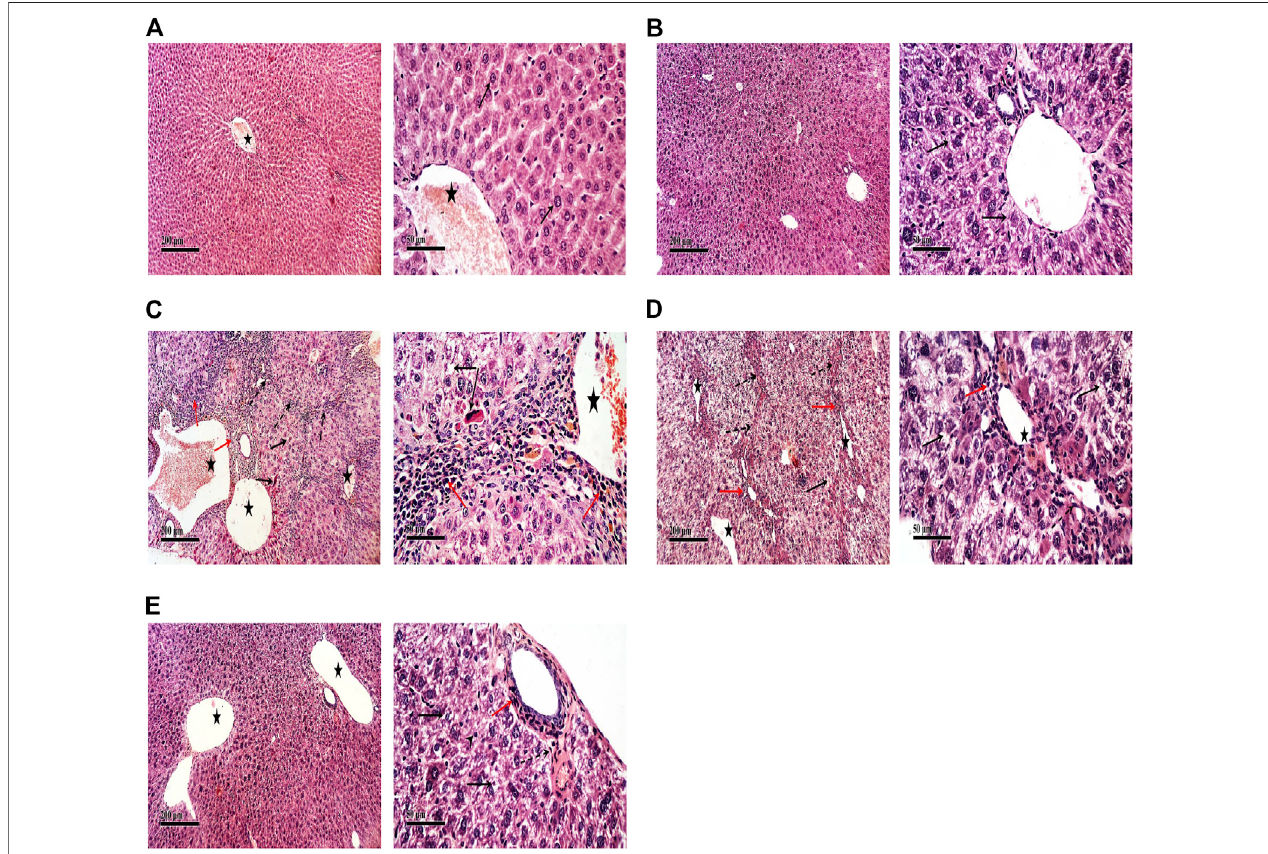
FIGURE 5 | Effect of DEN+CCl4 and TF-ODNs on histopathological features. (A) normal histologic structure showing central vein (star) from control group, (B) TFAS treated rats showing apparently normal histological features with minimal degenerative changes, (C) DEN+CCl4 intoxicated rats showing sever vacuolar degenerativeandnecrotichepatocellularchanges(blackarrow)accompaniedwithmanydilatedliverbloodvessels(star)andseverperiportalin fl ammatorycellsin fi ltrates (red arrow), (D) TFSC treated intoxicated rats showing slight amelioration of abnormal morphological changes with persistence of sever vacuolar degenerative of hepatocytes (arrow), (E) TFAS treated intoxicated rats showing moderate amelioration of morphological changes with dilated blood vessels and mild periportal in fl ammatory cells in fi ltrates (arrow head); DEN: N-diethyl nitrosamine; CCl4: carbon tetrachloride; TFSC: scrambled tissue factor oligodeoxynucleotides; TFAS: antisense tissue factor oligodeoxynucleotides.